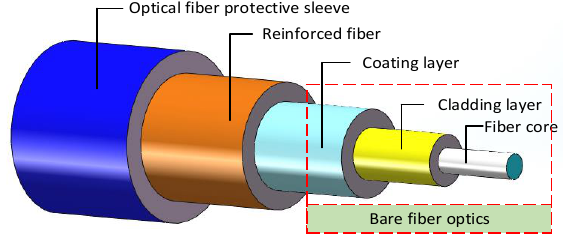
Figure 1. Schematic diagram of the FBG sensor’s structure.